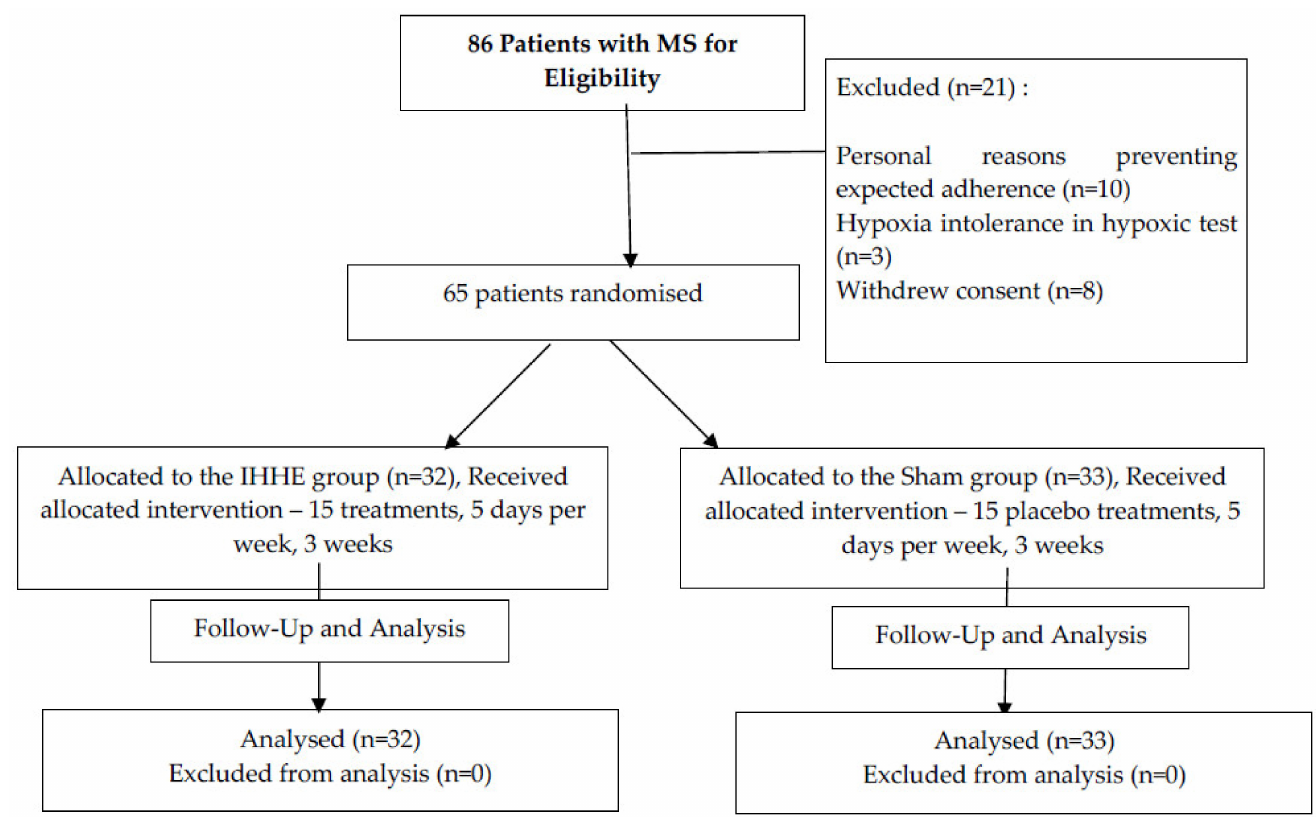
Figure 1. MS—Metabolic Syndrome; IHHE: intermittent hypoxic-hyperoxic exposure. IHHE